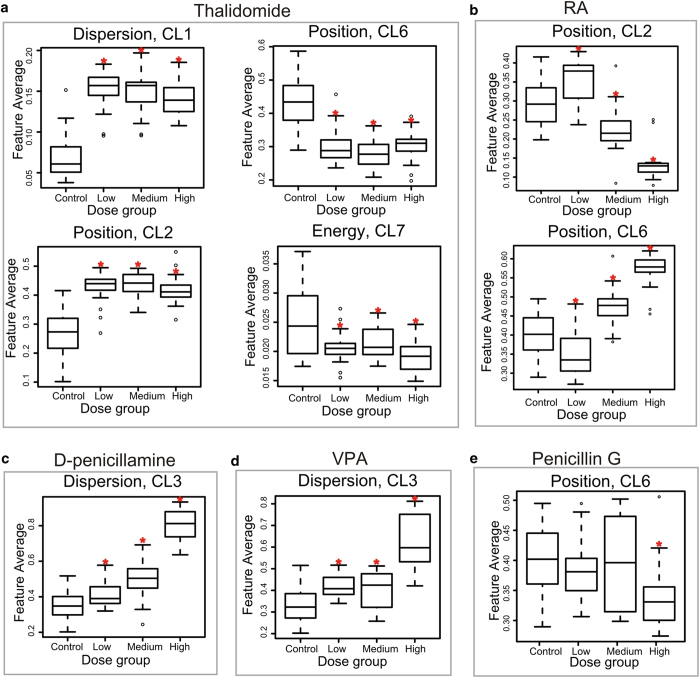
Teratogen screening results in the μP-hPSC model.(a-e) Boxplots of morphologic cluster readout, which showed clear dose-dependent disruption effects of each drug among the four test groups. The low, medium, high tested concentrations of each drug were 30 μM , 300 μM, 800 μM for Thalidomide in (a); 0.00036 μg/ml, 0.0036 μg/ml and 0.036 μg/ml for RA in (b); 200 μg/ml, 400 μg/ml and 800 μg/ml for D-penicillamine in (c); 0.1 mM, 0.4 mM, 0.8 mM for VPA in (d); 40 μg/ml, 200 μg/ml, and 1,000 μg/ml for Penicillin G in (e). *: p < 0.0083 in post-hoc analysis.